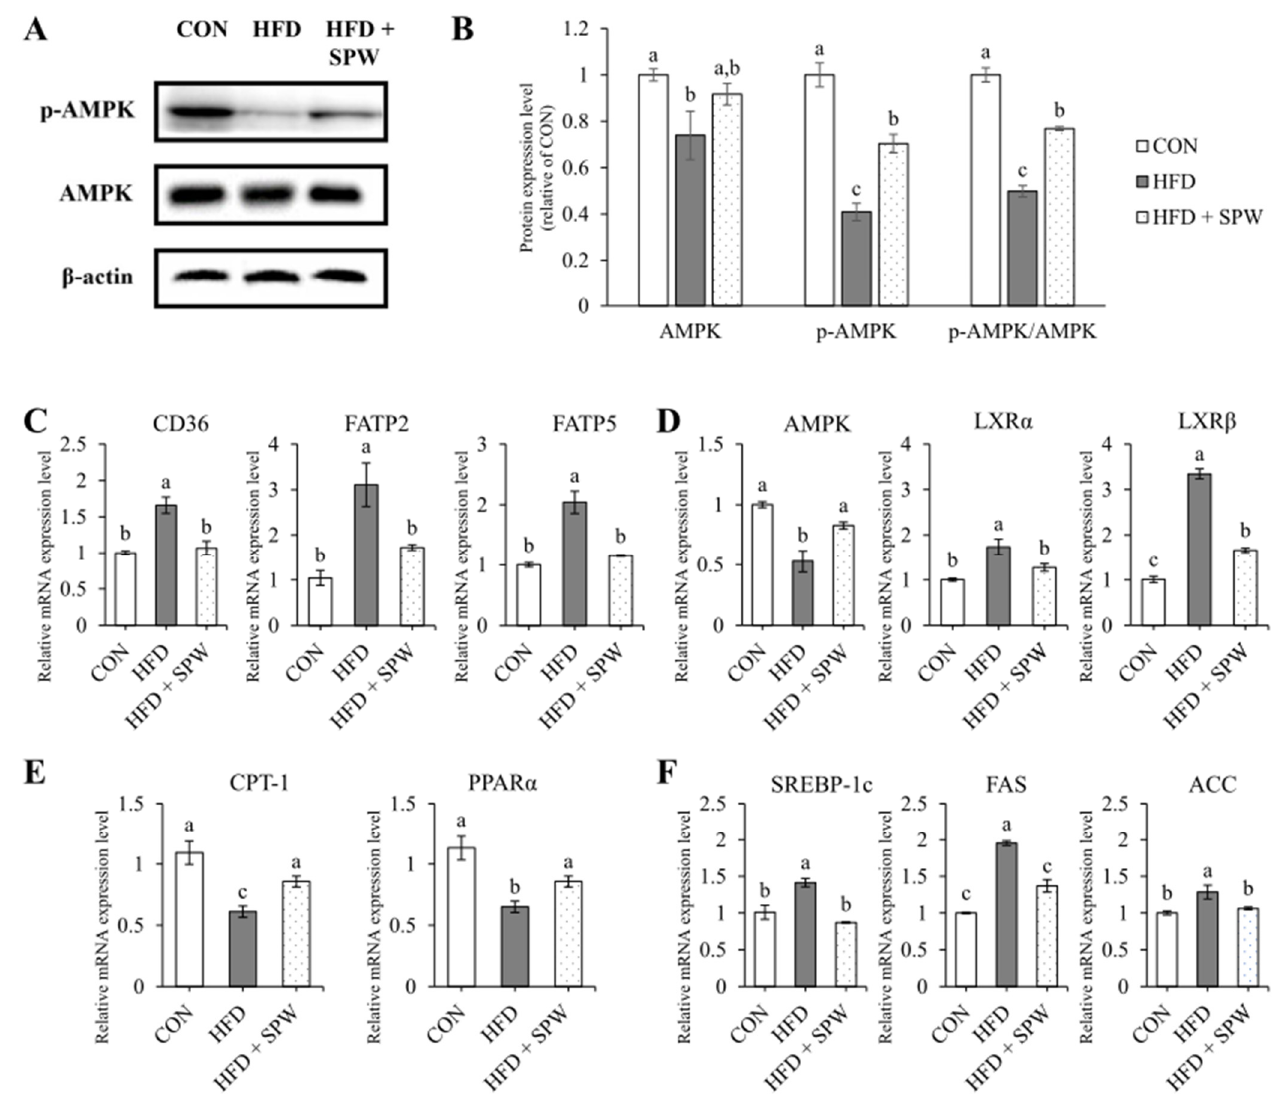
Figure 5. Salvia plebeia R. Br. water extract (SPW) intake regulated the gene expression of lipid metabolism factors in HFD-induced NAFLD mice. The protein expression level was measured by Western blotting. β -actin was used as standard for normalizing the expression. ( A ) Representative Western blot of AMPK, p-AMPK, and β -actin. ( B ) Normalized protein expression level. The mRNA expression level of ( C ) lipid uptake markers, CD36, FATP2, and FATP5; ( D ) lipid metabolism marker, AMPK; ( E ) lipid synthesis markers, SREBP-1c, FAS, and ACC; and ( F ) β -oxidation markers, CPT-1 and PPAR α . Data represents the mean ± SE (standard error, n = 5 for each group): CON, control; HFD, high-fat diet; HFD + SPW, HFD + 200 mg/kg/day SPW; NAFLD, non-alcoholic fatty liver disease; p-AMPK; phospho-AMPK. The different letters above the bar indicate statistical difference based on the Duncan multiple range test ( p < 0.05, a > b >